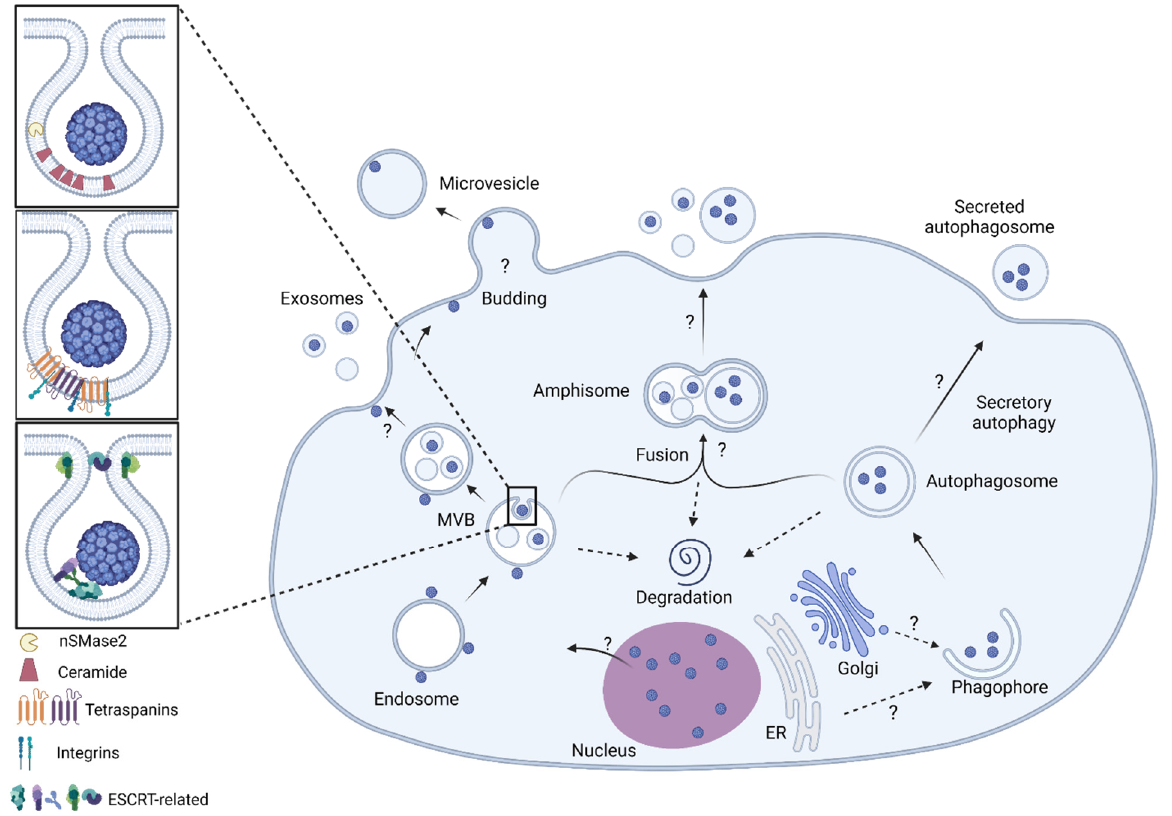
Figure 4. Potential JCPyV(+) EV biogenesis pathways. Exosomes, microvesicles, and secretory autophagosomes and their general biogenesis pathways are shown. Exosomes are produced by three non-mutually exclusive methods using (1) nSMase2 (top panel), (2) tetraspanins (middle panel), or (3) ESCRT-related proteins (bottom panel) to induce negative membrane curvature and produce multivesicular bodies (MVBs). MVBs can be directed for fusion with the plasma membrane by proteins (including RAB27A), for degradation, or for fusion with an autophagosome, producing an amphisome (middle). Amphisomes may be targeted for secretion by RAB27A [158–160]. Autophagosomes can be directed for secretion by the actions of RAB8A or GRASP65 (mechanism not well-defined) or targeted for degradation [155–158]. Nuclear escape for JCPyV is unknown. Schematic created with BioRender.com (accessed on 18 April 2022).